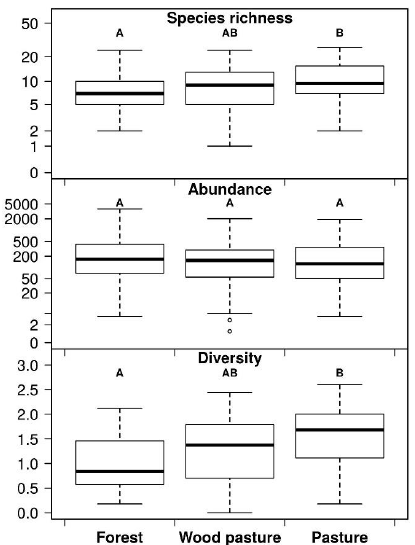
Figure 1. Summarised dung beetle species richness, abundance, and Shannon diversity per habitat types. Box plots show medians (thick line), lower, and upper quartiles (boxes), whiskers include the range of distribution without outliers. Different letters above the boxes show the significant differences between habitats.